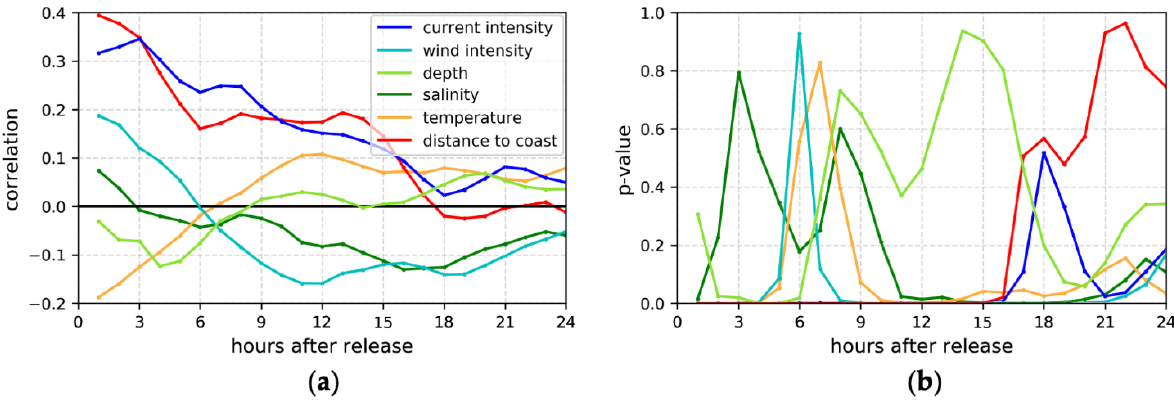
Figure 11. Pearson product–moment correlation coefficients between the hourly increase in separation distance and the instantaneous value of different fields ( a ) and p -value associated with the coefficients ( b ).